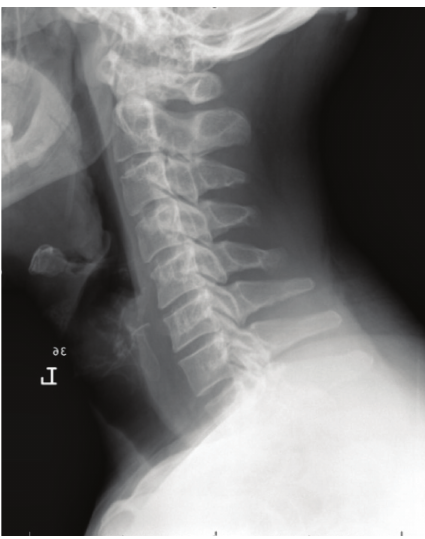
Figure 1: Lateral radiograph of the cervical spine in a patient who underwent laminoplasty. Note that there is an overall lordotic alignment which will allow for posterior drift once a posterior decompression is performed.